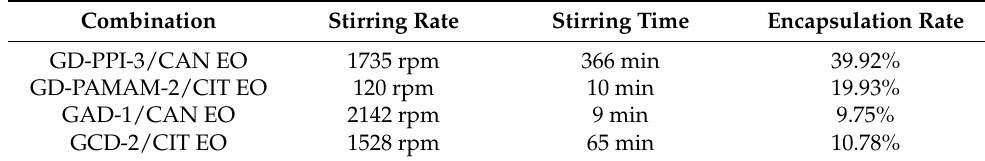
Table 8. Optimized values of stirring rate and time for all combinations obtained using RSMs. Combination Stirring Rate Stirring Time Encapsulation Rate GD-PPI-3/CAN EO 1735 rpm 366 min 39.92% GD-PAMAM-2/CIT